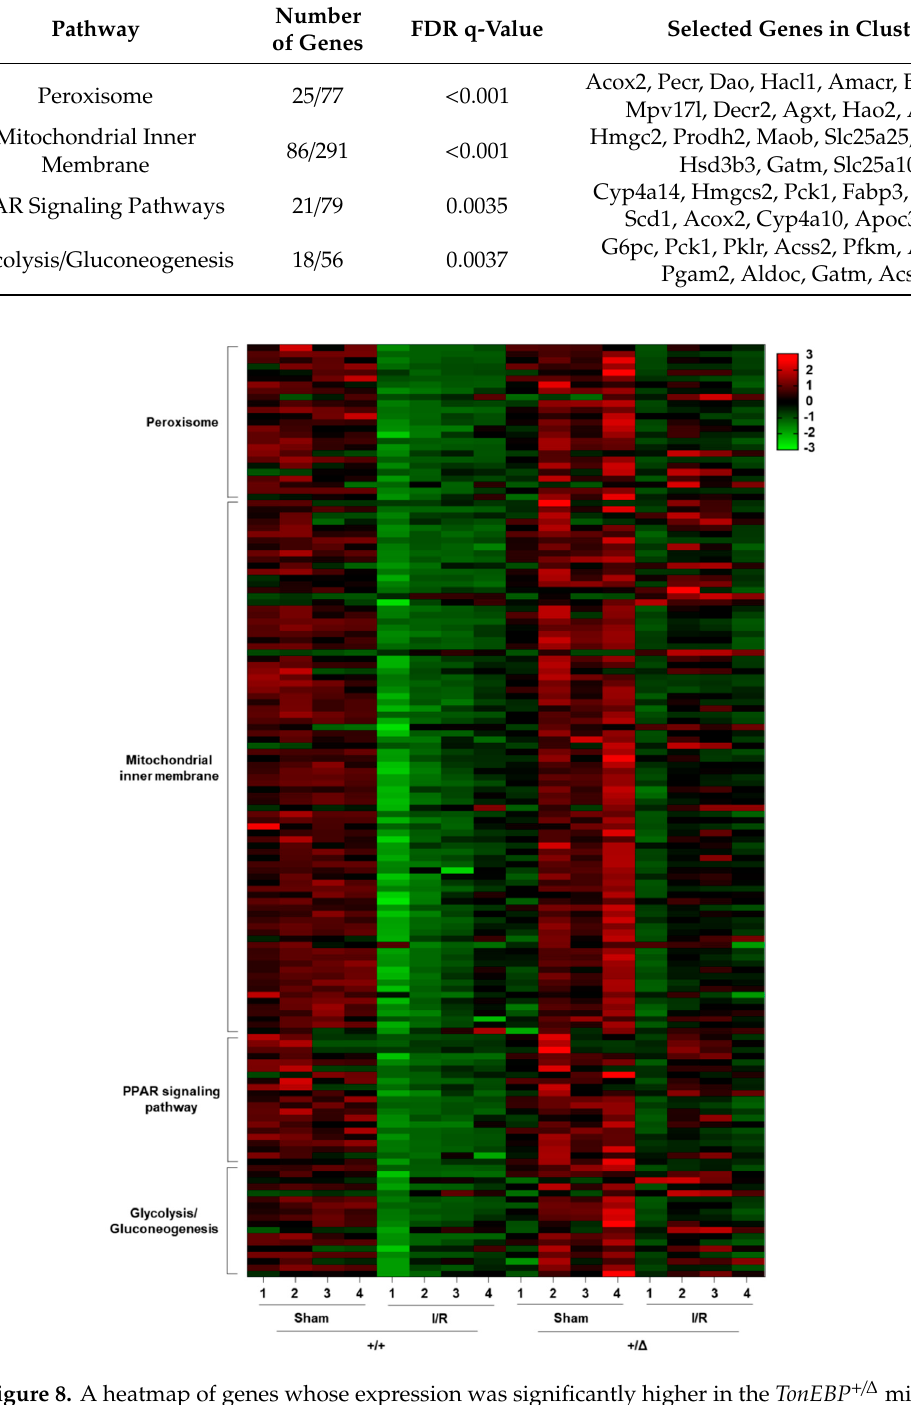
Figure 8. A heatmap of genes whose expression was significantly higher in the TonEBP +/ Δ mice over their TonEBP +/+ littermates after I/R treatment of kidneys, as described in Table 2. Numbers 1 to 4 at the bottom denote individual animals (n = 4).